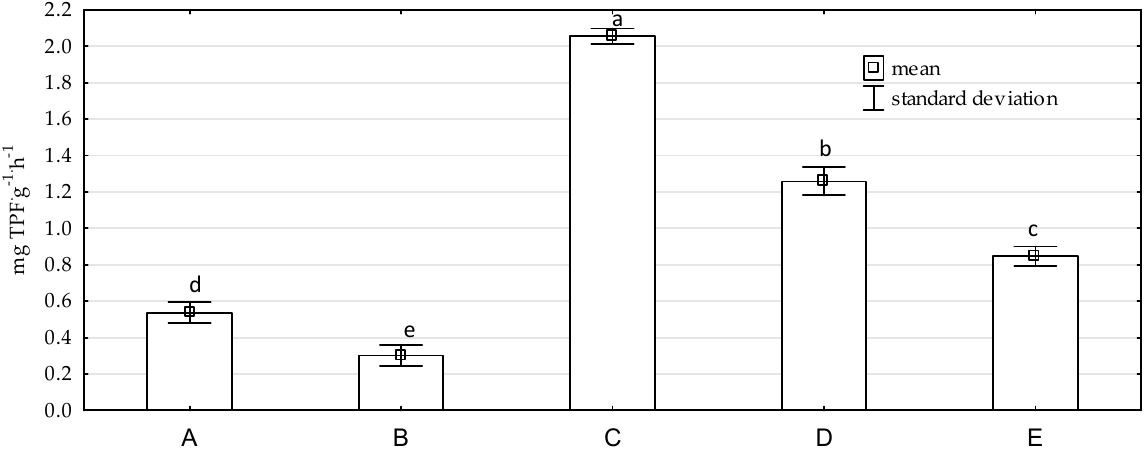
Figure 1. Activity of DHA in soil; A, B, C, D, E—explanations as in Table 1. The same lowercase letters above each column indicate that the average values of DHA activity (homogeneous group) are not significantly different at p <